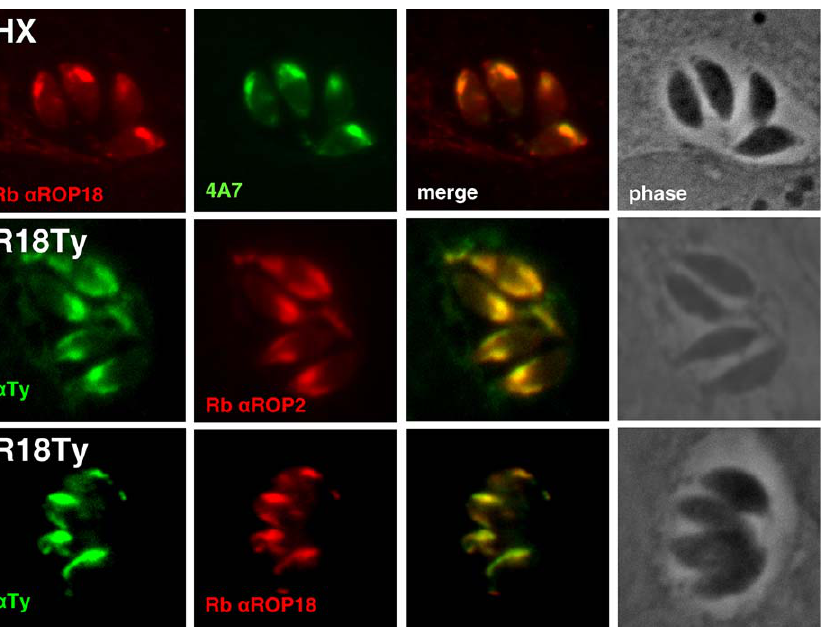
Figure 4. IFA Localisation of ROP18 in Intracellular Parasites In the upper row, intracellular HX tachyzoites were reacted with pre-immune or immune rabbit anti-ROP18 antibodies combined with mAb anti–ROP2- ROP4. In the lower rows, intracellular ROP18-Ty–transfected tachyzoites were reacted with mAb anti-Ty, combined with either rabbit anti-ROP2 serum or